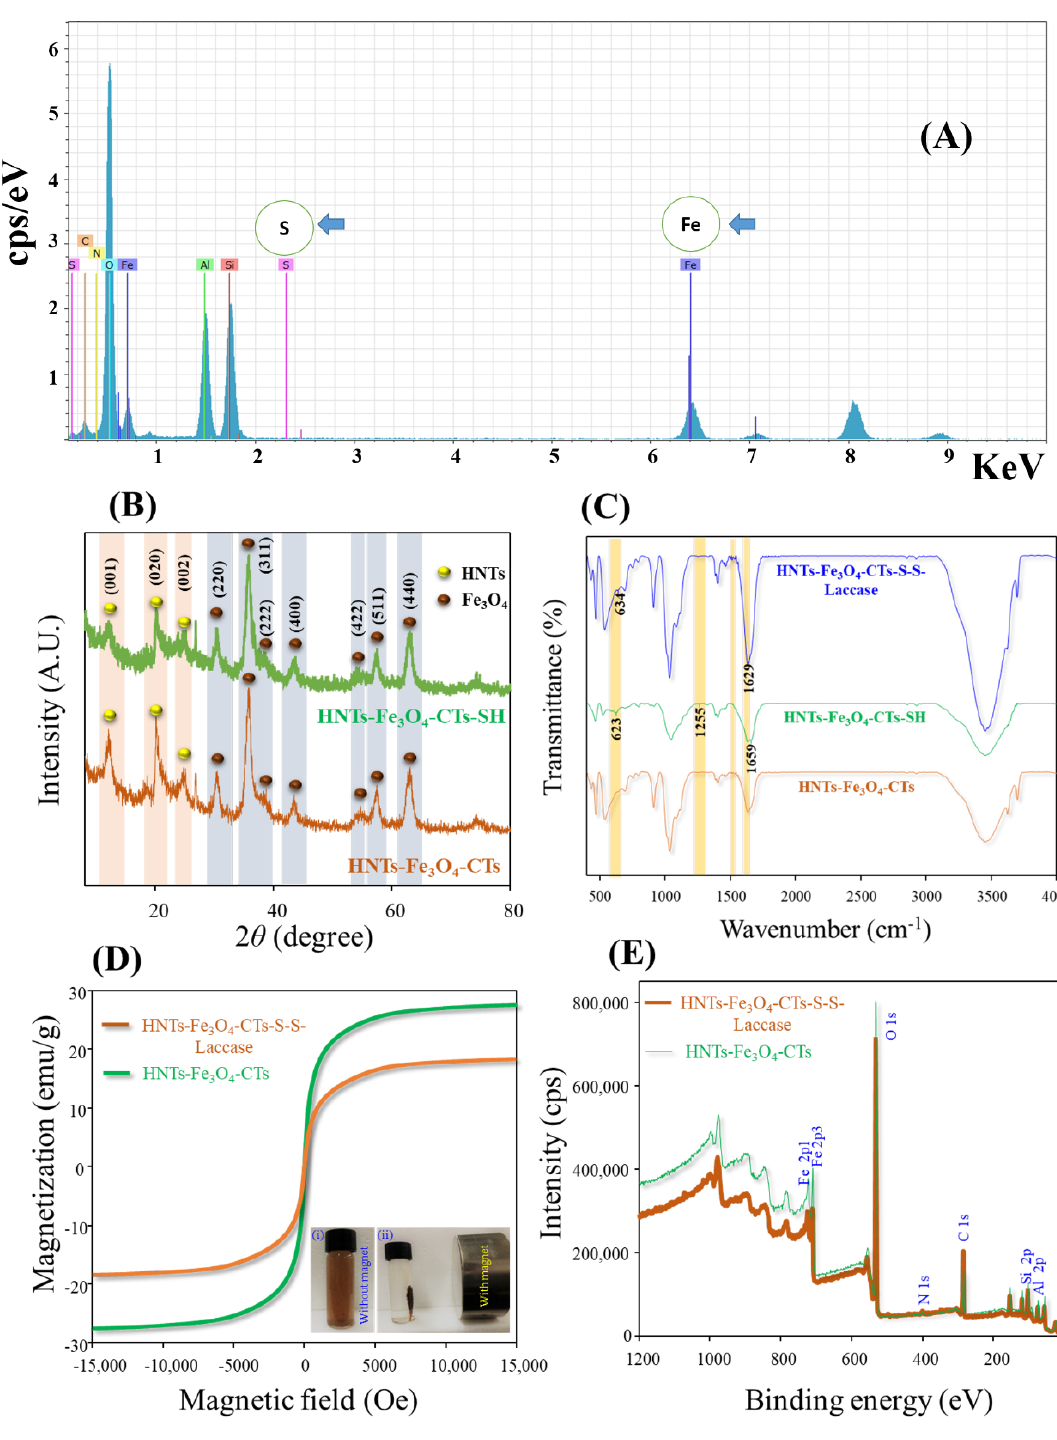
Figure 3. (A ) HR-TEM EDS analysis of HNTs-Fe 3 O 4 -CTs-SH, ( B ) XRD analysis of HNTs-Fe 3 O 4 -CTs and HNTs-Fe 3 O 4 -CTs-SH, ( C ) FT-IR analysis of HNTs-Fe 3 O 4 -CTs, HNTs-Fe 3 O 4 -CTs-SH, and HNTs-Fe 3 O 4 -CTs-S-S-Laccase ( D ) VSM analysis of HNTs-Fe 3 O 4 -CTs and HNTs-Fe 3 O 4 -CTs-S-S-Laccase inset ( i ) HNTs-Fe 3 O 4 -CTs-S-S-Laccase without magnet, and ( ii ) HNTs-Fe 3 O 4 -CTs-S-S-Laccase with magnet, ( E ) XPS analysis of HNTs-Fe 3 O 4 -CTs and HNTs-Fe 3 O 4 -CTs-S-S-Laccase.